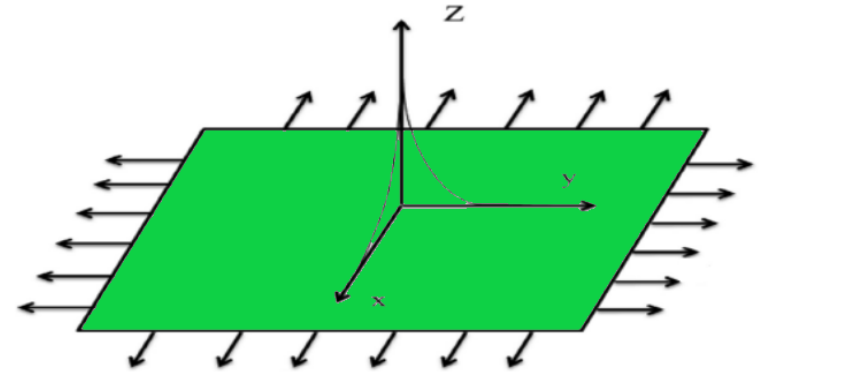
Figure 1. Geometrical description of the